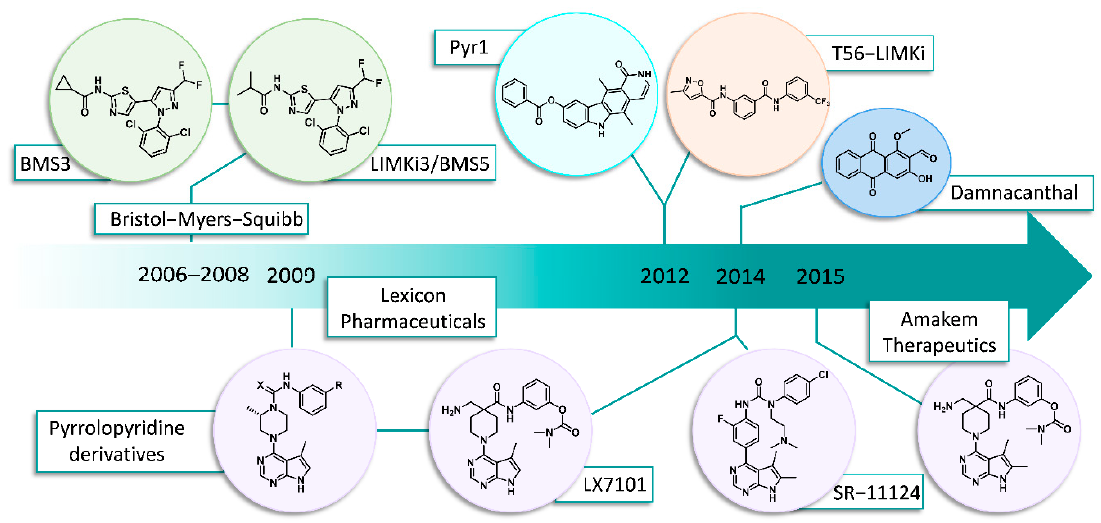
Figure 2. Chronological development of LIM Kinase inhibitors tested in vivo.